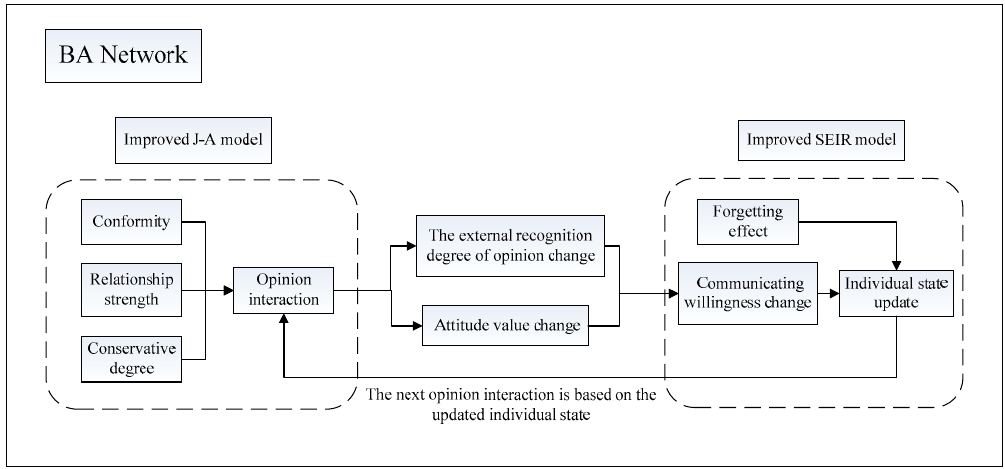
Figure 4. SEIR-JA (Susceptible-Exposed-Infected-Recovered–Jager-Amblard) model